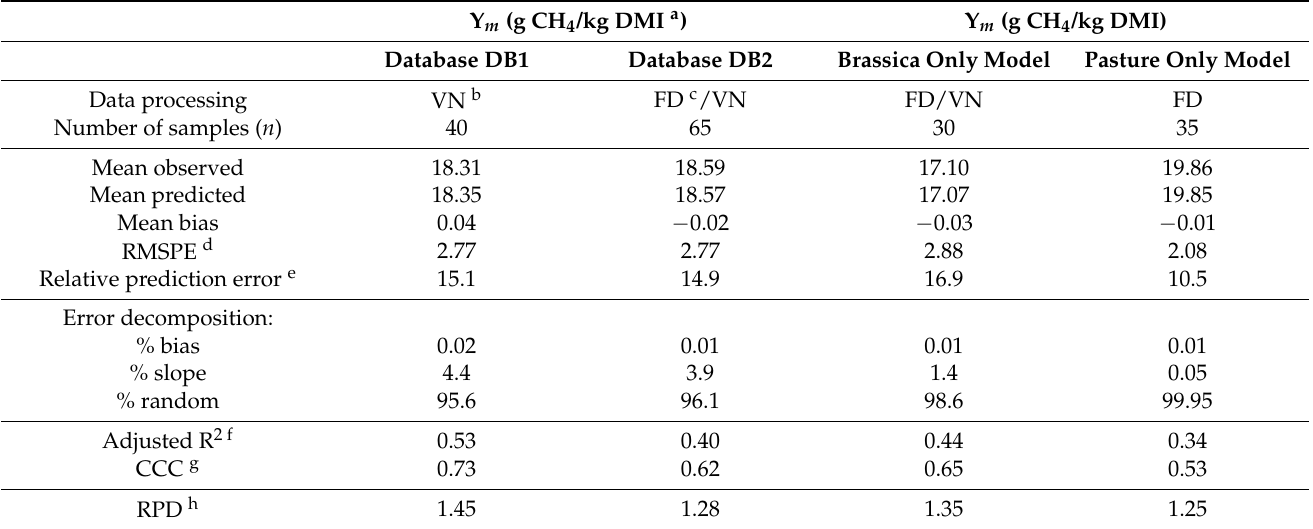
Table 3. Evaluation of the predictive models of methane (CH 4 ) yield (Y m ) generated from near- infrared reflectance spectra of feed samples from experiments in which animals were fed at 1.6 × metabolizable energy (ME) maintenance requirements. Statistics compare the performance of the model to predict Y m across all feed types in the